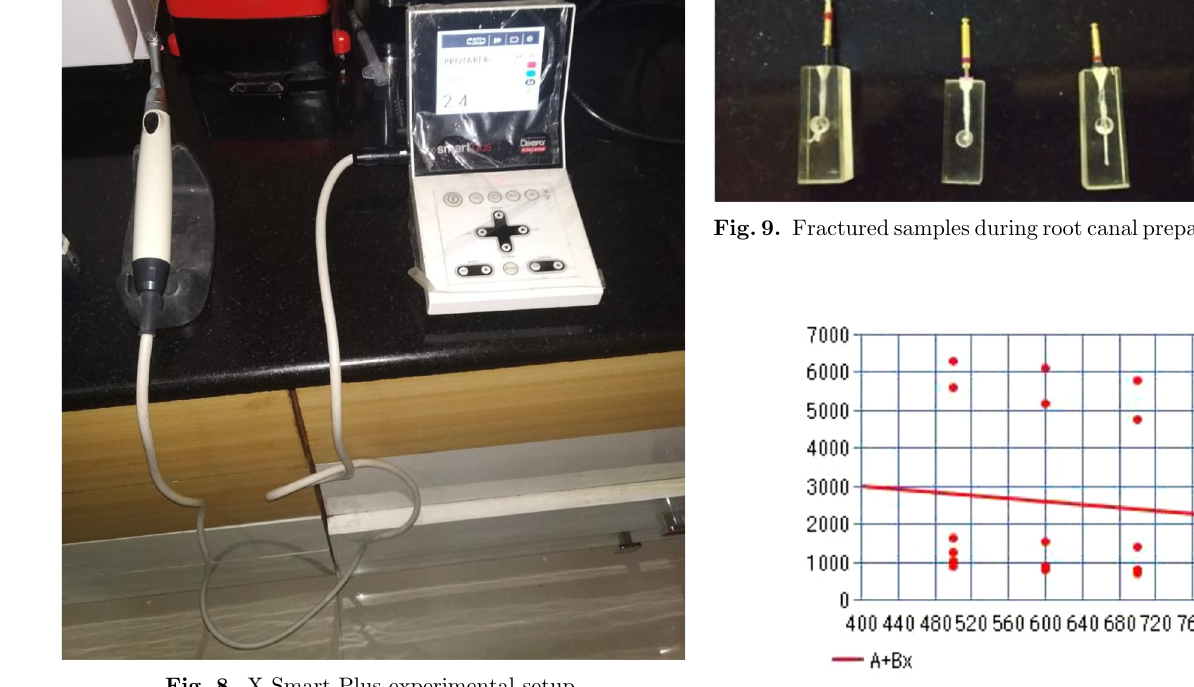
Fig. 10. Simple linear regression